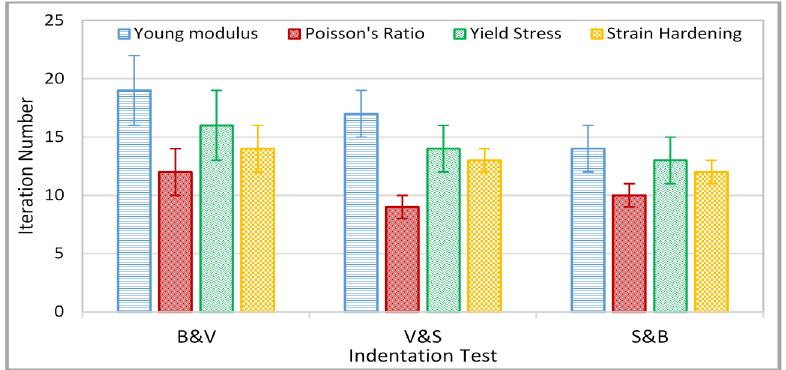
Figure 5. Optimization results of elastic plastic material properties based on (B&V), (V&S) and (S&B) indentation tests.